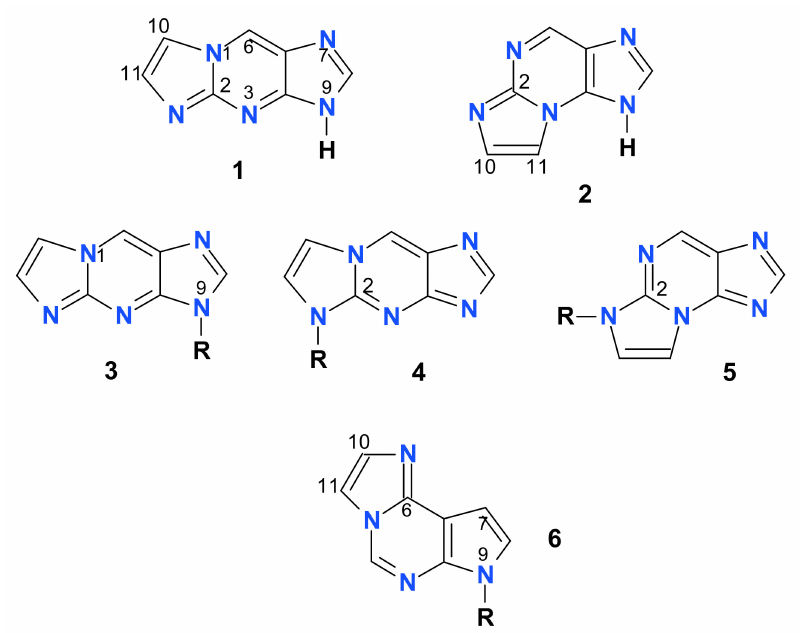
Figure 1. Structures of the nucleobase and nucleoside analogs investigated in this